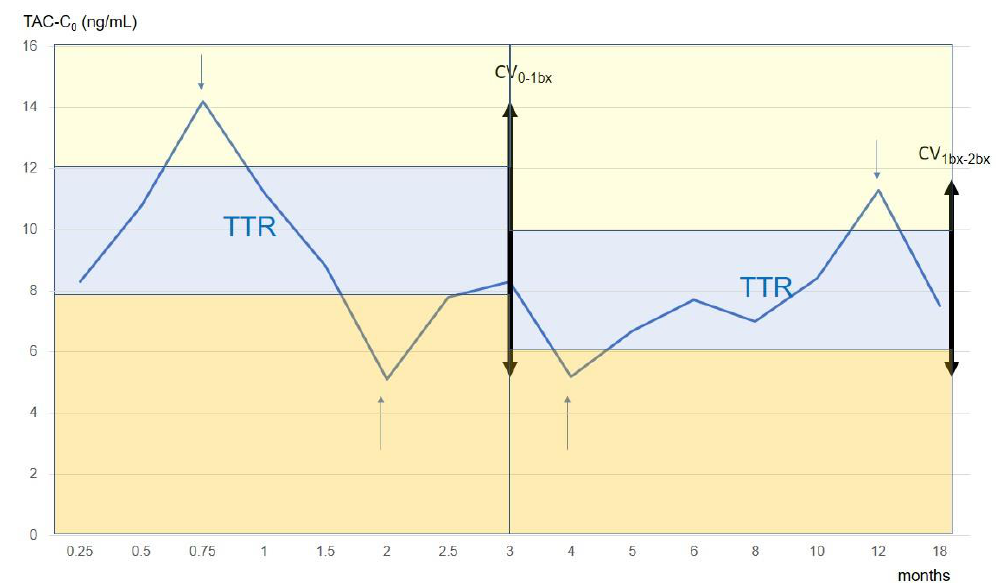
Figure 1. Evolution of tacrolimus trough levels during follow up in a patient from our cohort. TTR (blue area), time in the therapeutic range; times above (yellow area) and below (orange area) the therapeutic range are also shown. CV 0-1bx, coefficient of variability of tacrolimus between transplant and the first surveillance biopsy (29.3%); CV 1bx-2bx, coefficient of variability of tacrolimus between the first and the second surveillance biopsies (24.5%). In the x -axis, time of follow up (months) is presented, while in the y -axis, tacrolimus trough levels (ng/mL) are depicted. Arrows indicated determinations above and below the therapeutic range.